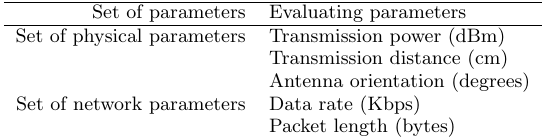
Table 2: Evaluation of hardware with two different sets of physical and network parameters.